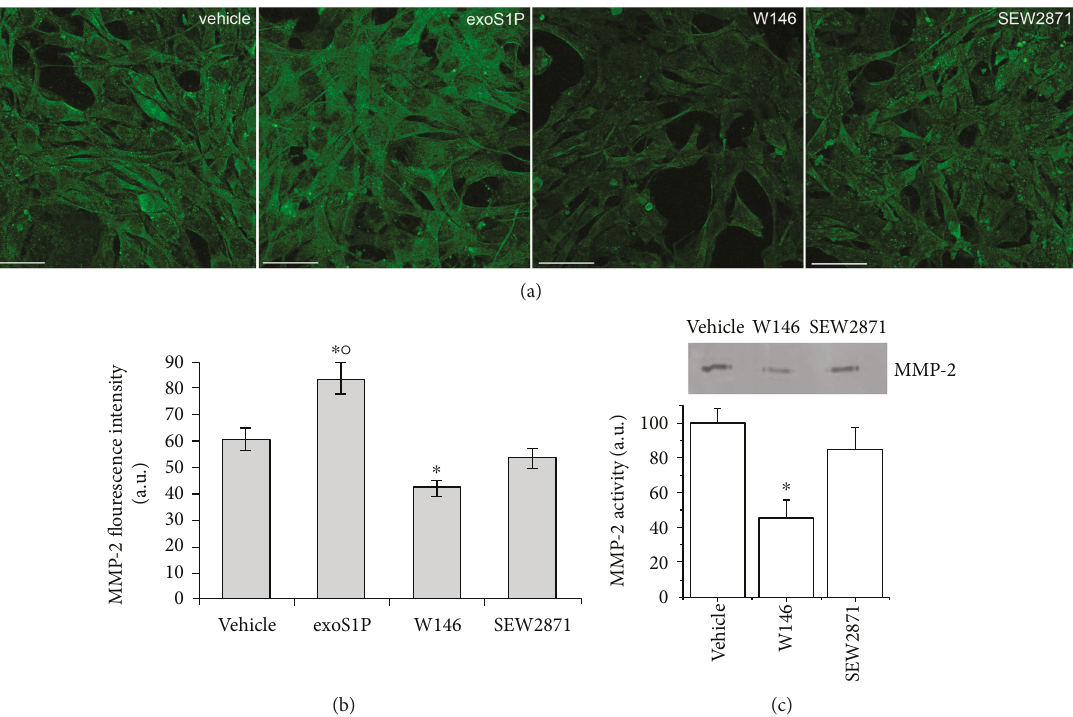
Figure 2: MMP-2 expression and activity. BM-MSCs were cultured for 48 h in the absence (vehicle) or in presence of 1 μ M exogenous sphingosine-1-phosphate (exoS1P) or 2 μ M S1PR1 receptor antagonist, W146, or 2 μ M S1PR1 receptor agonist, SEW2871. (a) Representative immuno fl uorescence confocal images of fi xed cells on glass coverslips immunostained with antibodies against MMP-2 (green). Scale bar 50 μ m. The images are representative of at least three independent experiments with similar results. (b) Densitometric analysis of the intensity of the MMP-2 fl uorescence signal performed on digitized images. (c) Zymography. A representative gelatin zymography of MMP-2 from conditioned media obtained from BM-MSCs incubated in absence (vehicle) or in presence of W146 or SEW2871 for 48h. Densitometry scanning from at least three separate experiments was performed and data, expressed as relative OD values (a.u.) to those of control group (vehicle) set to 100, are reported in the histogram. Data are mean ± S.E.M. Signi fi cance of di ff erence in (b) (one-way ANOVA and Newman-Keuls multiple comparison tests), ∗ p < 0 05 versus vehicle, ° p < 0 05 versus SEW2871; in (c) (Student ’ s t -test), ∗ p < 0 05 versus